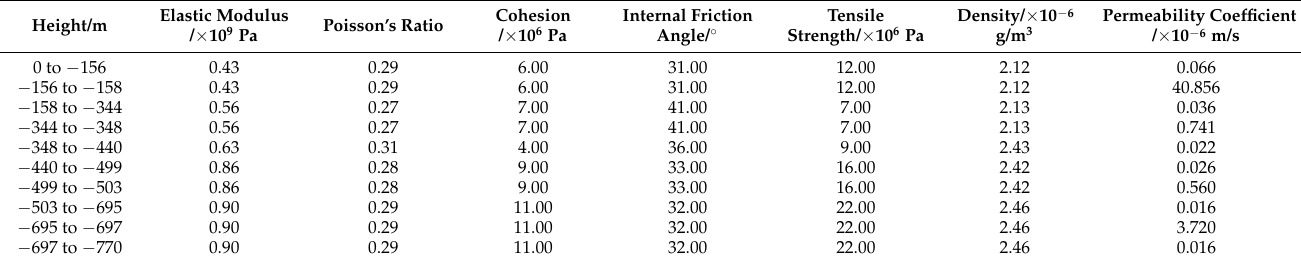
Table 4. Model total geological parameters at different depths.